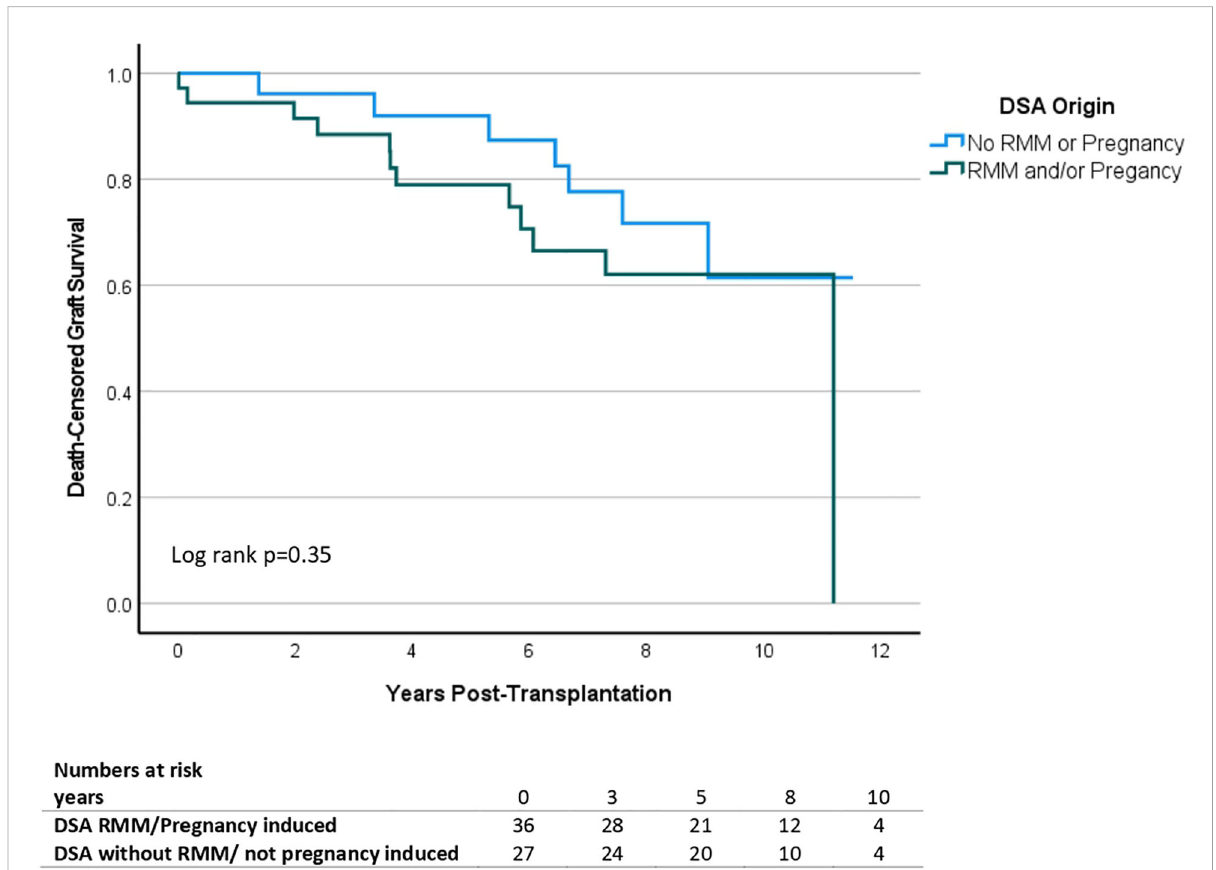
FIGURE 4 Kaplan Meier survival analysis of acute antibody mediated rejection according to origin of donor-speci fi c antibodies. Comparison of DSA from a previous transplant (n=19), DSA from a pregnancy (n=16), DSA from both (n=1), men with DSA not from a previous transplant (n=11) and females with DSA not from a previous transplant or a pregnancy